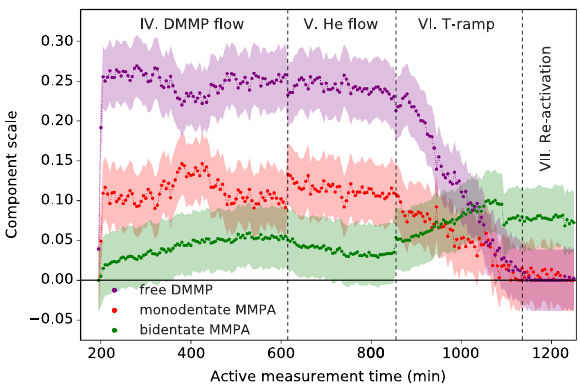
Fig. 7 Relative binding component scale factors. Component scale factors resulting from re fi nement of the second model using simulated PDFs of free DMMP, monodentate MMPA, and bidentate MMPA from DFT calculations. These values do not represent atomic fractions of the respective states and should be assessed qualitatively as trends in ability of simulated signals to best describe the signals not accounted for by the starting framework. Errors are plotted as 3× the average e.s.d. from the re fi nement.